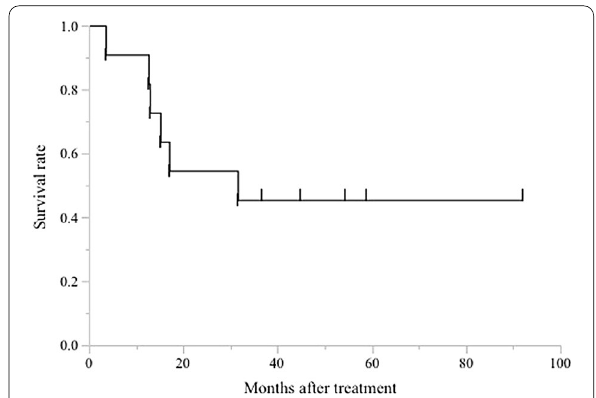
Fig. 2 Survival curve for overall survival of 11 patients was analyzed with the use of Kaplan–Meier analysis